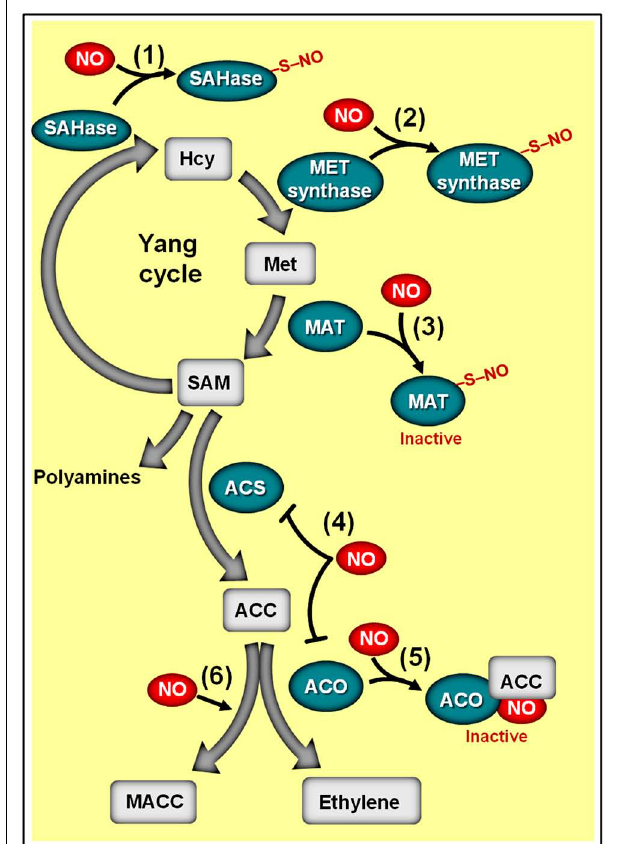
FIGURE 8 | Schematic representation of NO-ethylene antagonistic interactions. The methylmethionine cycle enzymes adenosyl homocysteinase (SAHase) (1) and methionine synthase (MET synthase) (2), whose activities are responsible for the production of homocysteinase (Hcy) and methionine (Met), respectively, may undergo S -nitrosylation. (3) Additionally, the activity of the Arabidopsis methionine adenosyltransferase 1 (MAT1) can be suppressed by S -nitrosylation, thereby repressing the conversion of methionine (Met) to S -adenosyl methionine (SAM). (4) In ripening climacteric fruits, NO has been shown to inhibit the transcript levels of 1-aminocyclopropane 1-carboxylic acid (ACC) synthase (ACS) and/or ACC oxidase (ACO). (5) NO can also inhibit ACO activity by directly binding this enzyme, resulting in the ACO–NO binary complex, which subsequently originates a ternary stable complex ACO–NO–ACC. (6) NO-driven accumulation of non-volatile ACC metabolite 1-malonyl aminocyclopropane-1-carboxylic acid (MACC) has also been reported. Biosynthetic enzymes are represented with green ovals and metabolic substrates and products with gray rectangles. Protein S -nitrosylation is represented by “–S–NO.” Note that the impact of S -nitrosylation on the activities of SAHase, MET synthase, and ACS remains to be